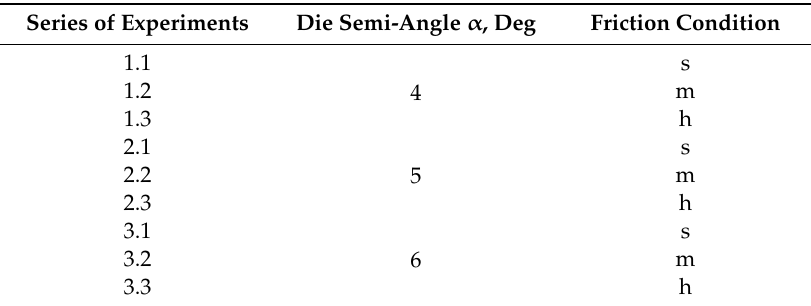
Table 2. Drawing experimental regimes.